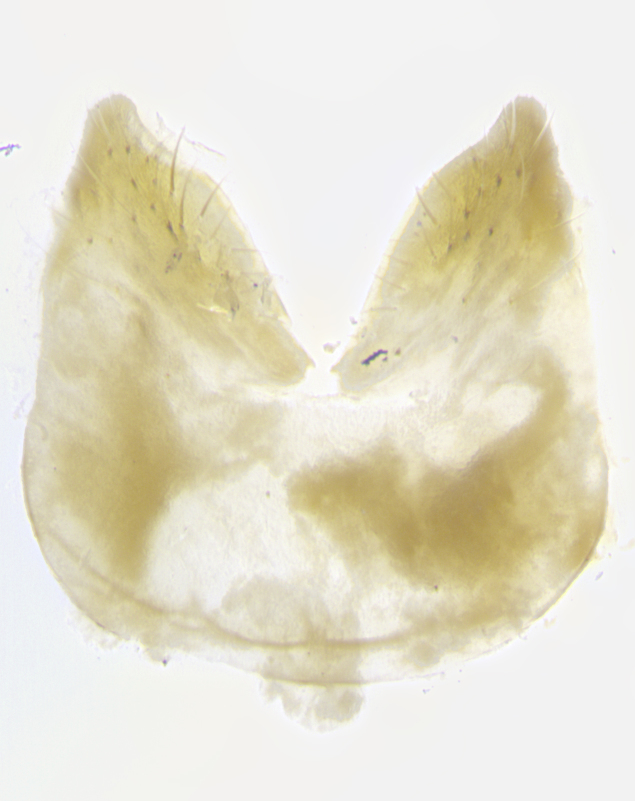
sternite 5, ventral view.